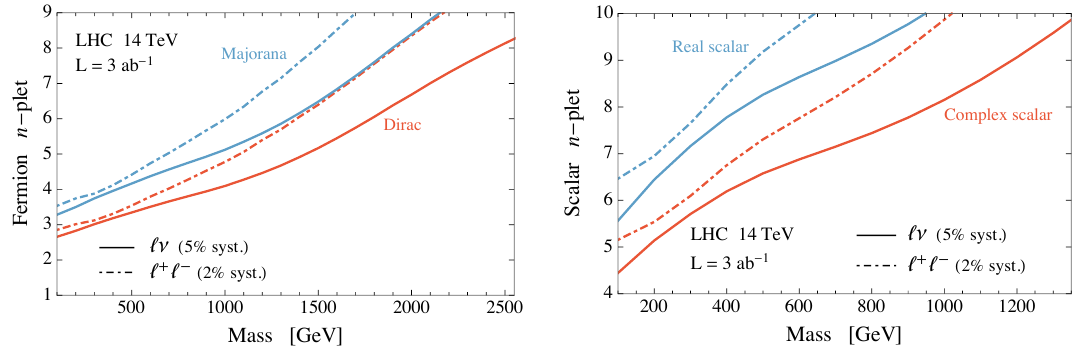
Figure 2 . Expected 95% CL exclusion limits at the HL-LHC. The left and right panels show the bounds on fermion and scalar multiplets respectively. The vertical axis reports the e(cid:11)ective n of the multiplet, while the horizontal axis gives the mass of the states in the multiplet, which are assumed to be (almost) degenerate. The solid and dot-dashed lines correspond to the bounds from the ‘(cid:23) and ‘ + ‘ (cid:0) channels respectively. The blue (red) lines give the bounds for Majorana (Dirac) fermions on the left panel and for real (complex) scalars in the right